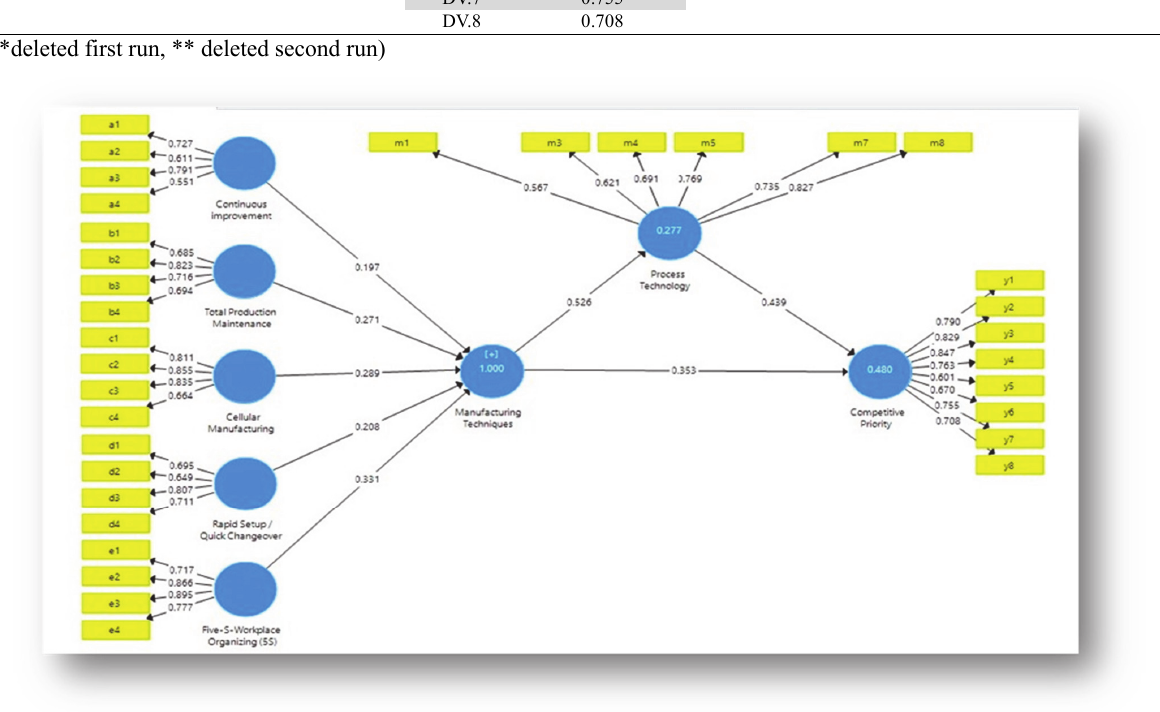
Fig. 2. Model of Standerdized Loading and Path Coeffecients For Thetrimmed